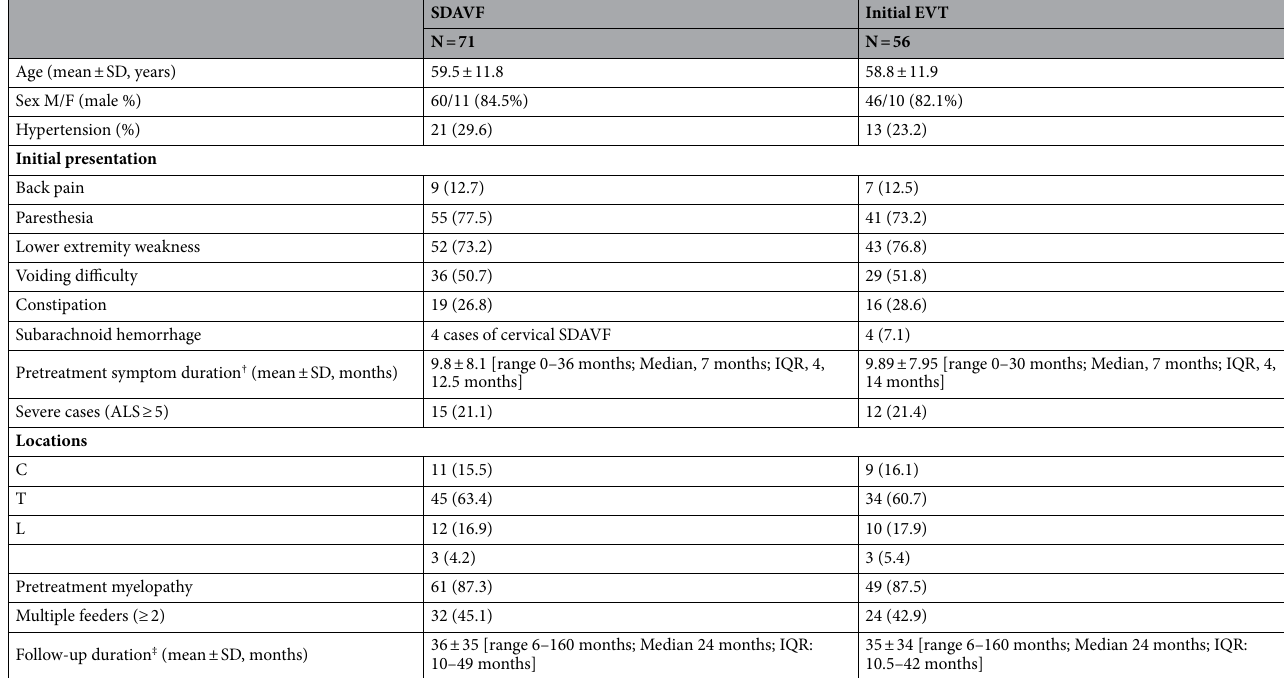
Table 2. Clinical information and radiological findings for 71 patients diagnosed with spinal dural arteriovenous fistula. SDAVF spinal dural arteriovenous fistula; ALS Aminoff-Logue scale; C cervical; T thoracic; L lumbar; S sacral; MRI magnetic resonance image; SI signal intensity; VB vertebral body. † , ‡ Duration is reported as both the mean ± standard deviation (SD) and median with interquartile range (IQR).